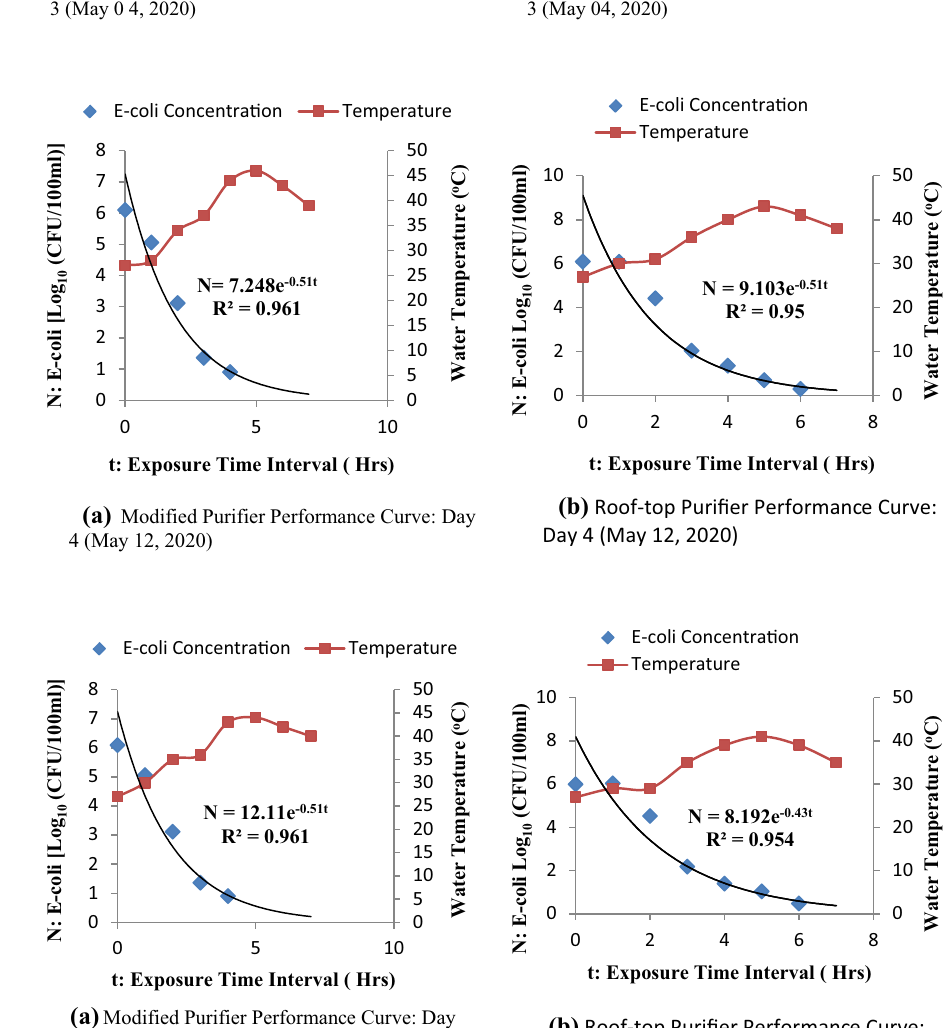
N = 7.979e -0.56t R² = 0.930